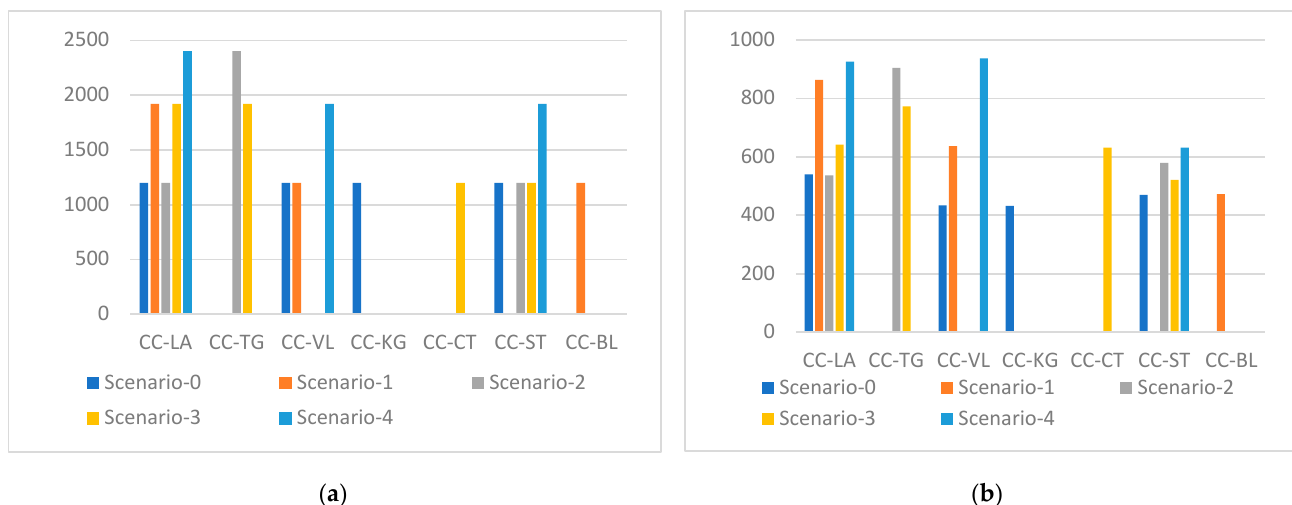
Figure 12. Scenario’s crossdocking center locations ( a ) Capacity; ( b ) workforce level.